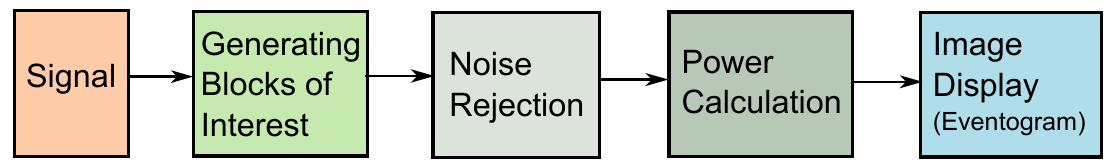
Figure 2. Flowchart for generating an eventogram . Generating an eventogram consists of four main stages: feature extraction (generating potential blocks using two moving averages), noisy events rejection, power calculation, and image